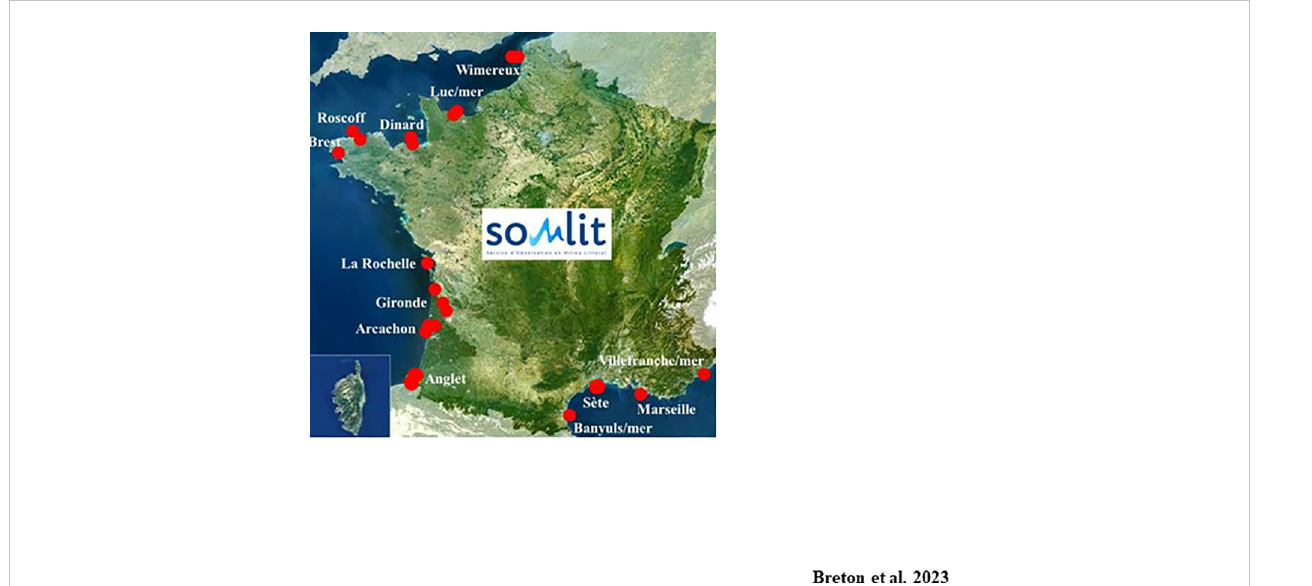
FIGURE 1 Location of the sites and stations belonging to the French coastal monitoring network SOMLIT (the logotype is in the center of the map).